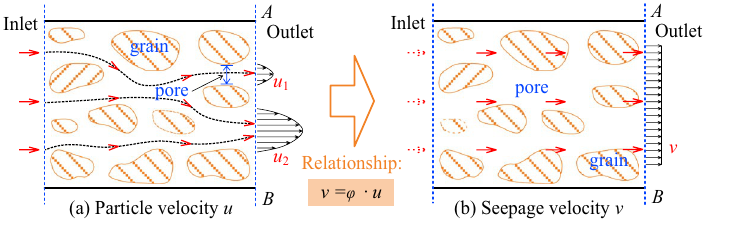
Figure 1. Basic definition of seepage